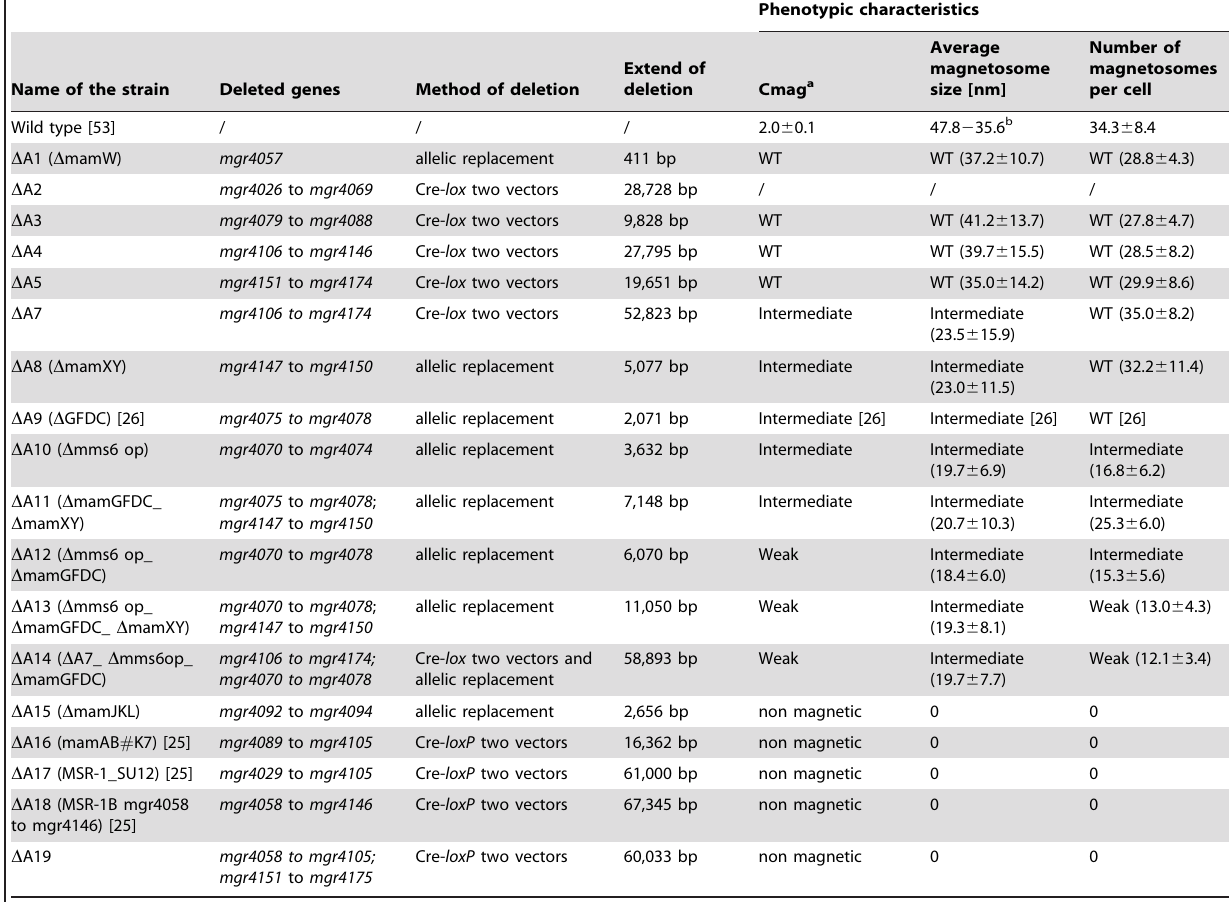
Table 1. Characteristics of MAI deletion